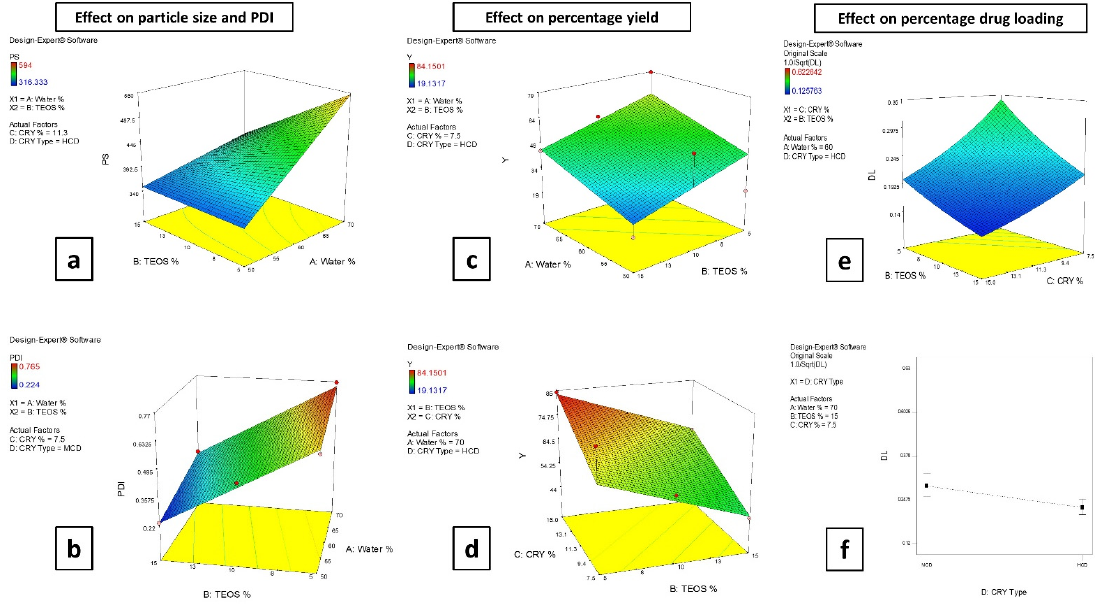
Figure 1. Response surface plots showing the effect of the aqueous phase percentage (Water %) and TEOS percentage (TEOS %) on particle size; PS ( a ), on polydispersity index; PDI ( b ) and on percentage yield; Y ( c ). The effect of TEOS percentage (TEOS %) and cryoprotectant percentage (CRY%) on percentage yield; Y ( d ) and on percentage drug loading; DL ( e ). The effect of cryoprotectant type (CRY Type) on percentage drug loading; DL ( f ).